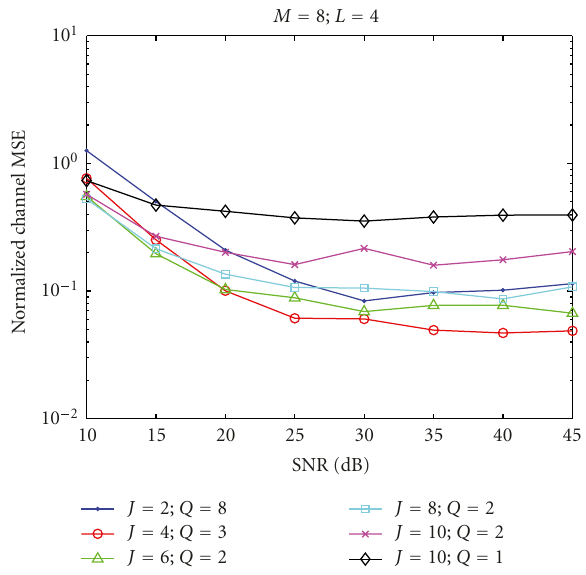
Figure 8: Normalized channel MSE performance for a time- varying channel.